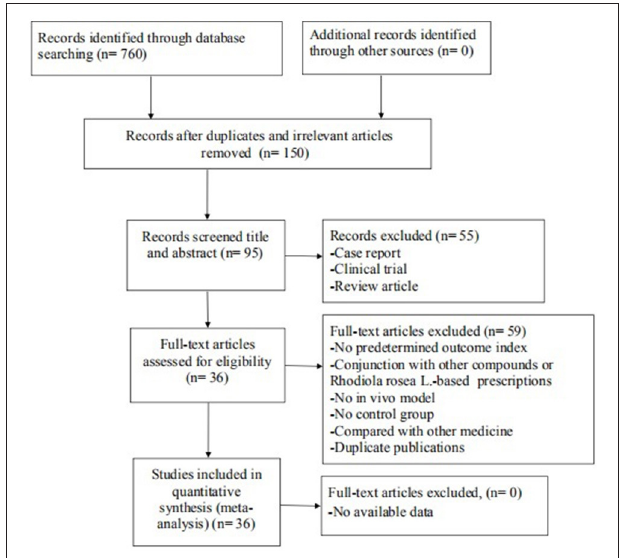
FIGURE 1 | Summary of the process for identifying candidate